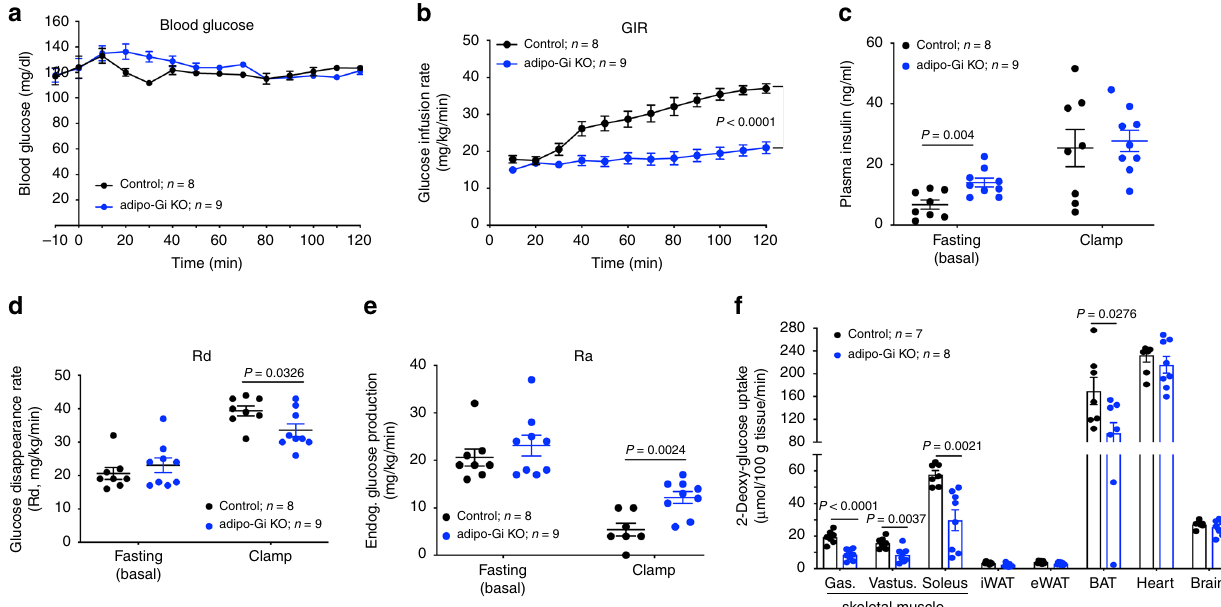
Fig. 3 HFD adipo-Gi KO mice show severe insulin resistance in a hyperinsulinemic-euglycemic clamp study. Clamp studies were carried out with adipo- Gi KO mice and control littermates (males) that had been maintained on a HFD for 12 weeks. a Blood glucose levels during the course of the clamp study. b Glucose infusion rate (GIR). c Plasma insulin levels (basal state and during clamp). d Glucose disappearance rate (Rd). e Rate of endogenous glucose production rate (Ra). f Glucose uptake by gastrocnemius muscle (Gas.), vastus muscle (Vas.), soleus muscle, iWAT, eWAT, BAT, heart, and brain during the clamp. Data are given as means ± s.e.m. ( n = 8 or 9 per group). P values are indicated in the different panels ( b : two-way ANOVA followed